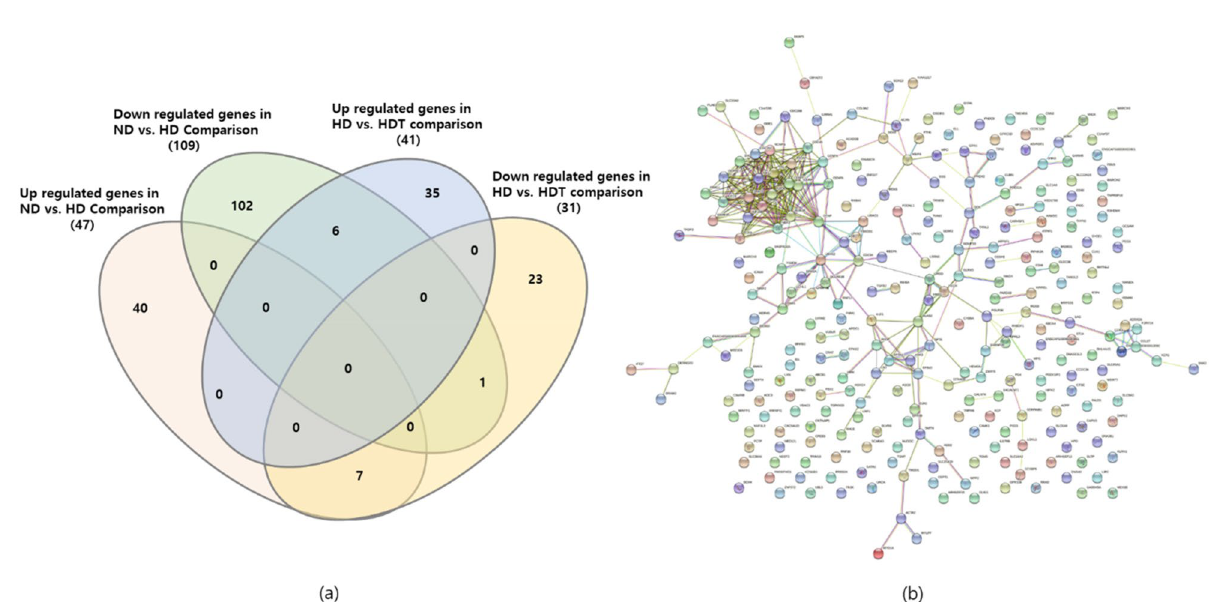
Figure 4. Venn diagram and protein–protein network of DEGs. ( a ) Common DEG in between ND to HD and HD to HDT groups. ( b ) Protein–protein interaction network of all DEG found in the study. ND normal diet group, HD high energy intake group, HDT high energy intake with BG&SW supplements treatment